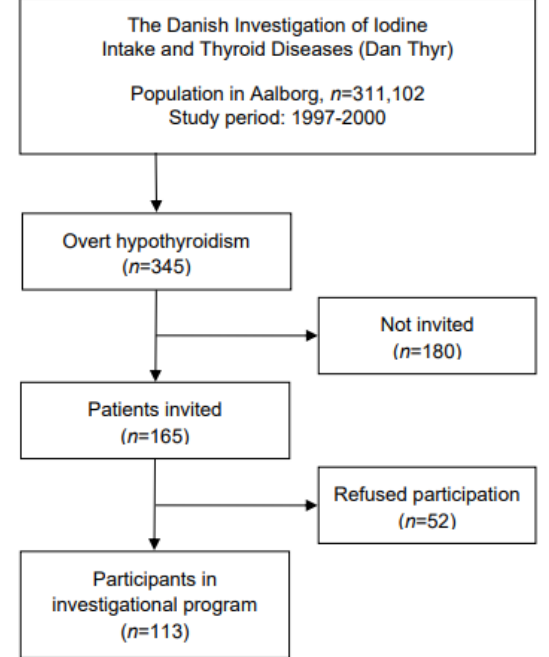
Figure 1: Flowchart depicting the origin and se- lection of hypothyroid cases ( n =345) and partici- pants in investigational program ( n =113)